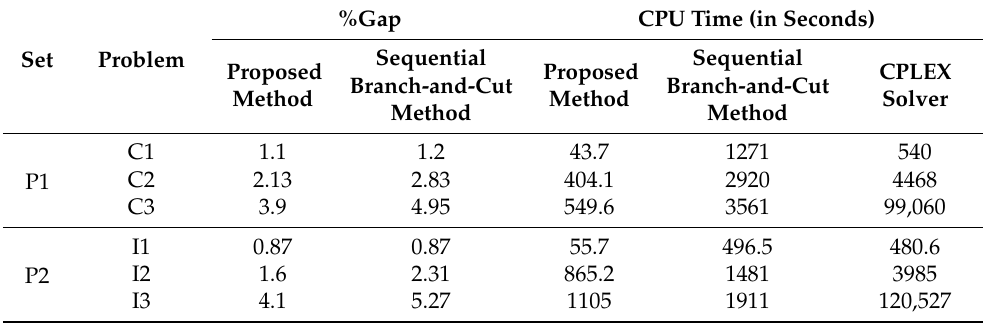
Table 2. Comparison between proposed method, sequential branch-and-bound, and